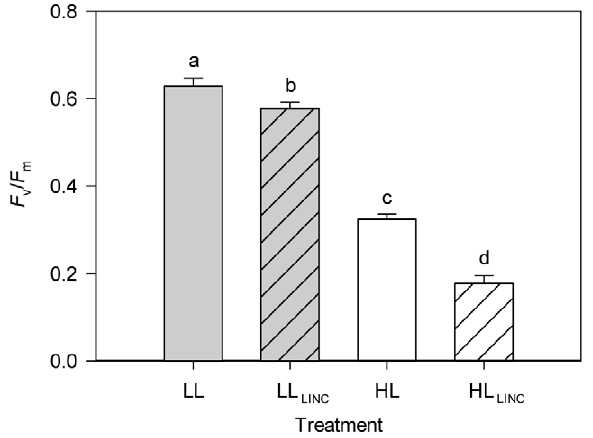
Figure 4. Maximum quantum yield of PSII ( F v / F m ) in Phaeodac- tylumtricornutum . Samples were dark-adapted for 10 min. Treatments (1 h duration): LL (low light, 40 m mol photons m 2 2 s 2 1 ); HL (high light, 1,250 m mol photons m 2 2 s 2 1 ); LL LINC (low light with LINC); and HL LINC (high light with LINC). Mean 6 standard deviation (n=4). Different letters indicate significant differences between treatments ( P , 0.01).